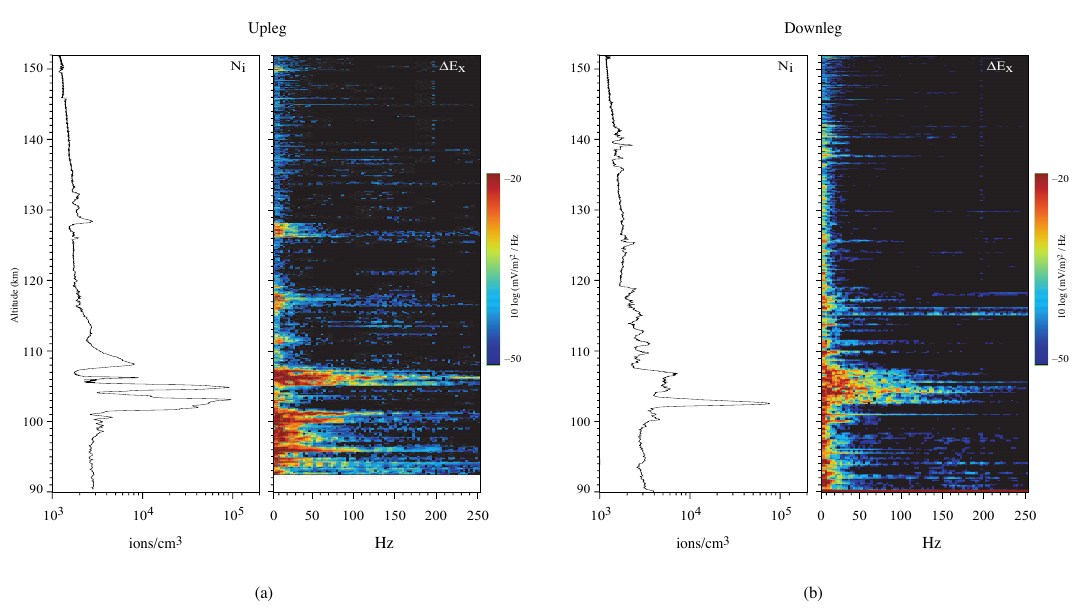
Fig. 12. Spectrograms of the filtered E x data (right hand panels) plotted alongside the plasma density data (left hand panels) for the upleg (a) and downleg (b)